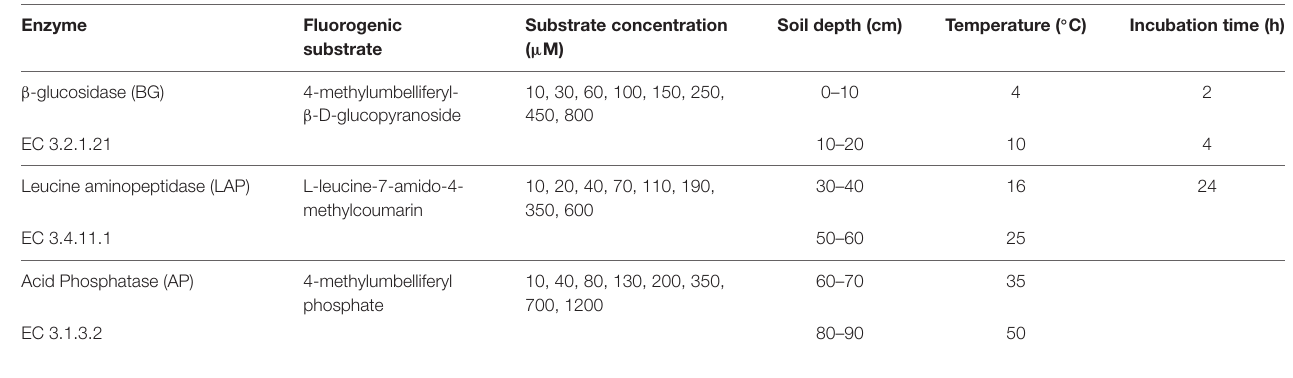
TABLE 1 | Experimental set-up of enzyme potential activity assays.